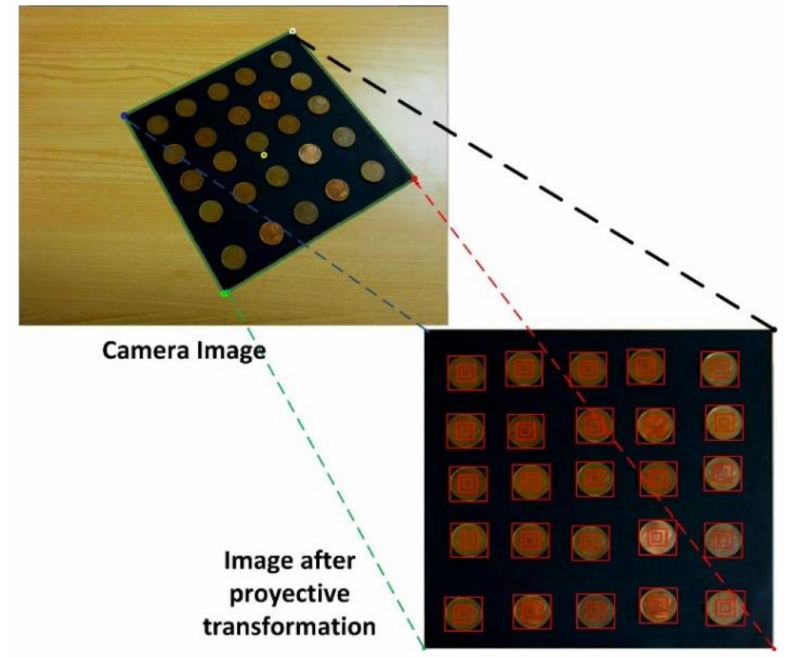
Figure 5. Image before and after the